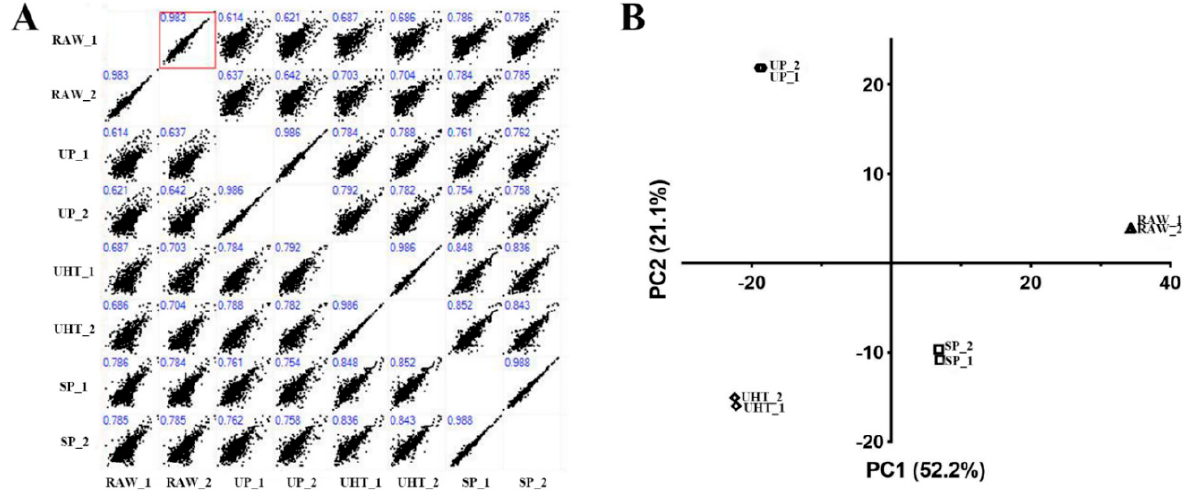
Figure 3. Pearson correlation score diagram ( A ) showing the correlation of caprine MFGM proteins between the different experimental groups. The score in the upper left corner of each small scatter plot is the R value of the experimental groups on the corresponding abscissa and ordinate. PCA score plot ( B ) showing the identified and quantified caprine MFGM proteins of the different heat treatment